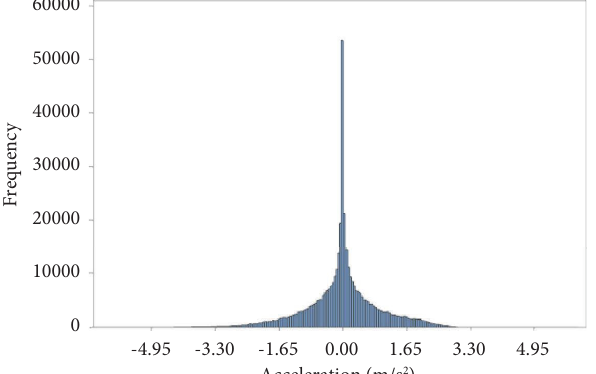
Figure 4: Distribution of acceleration in